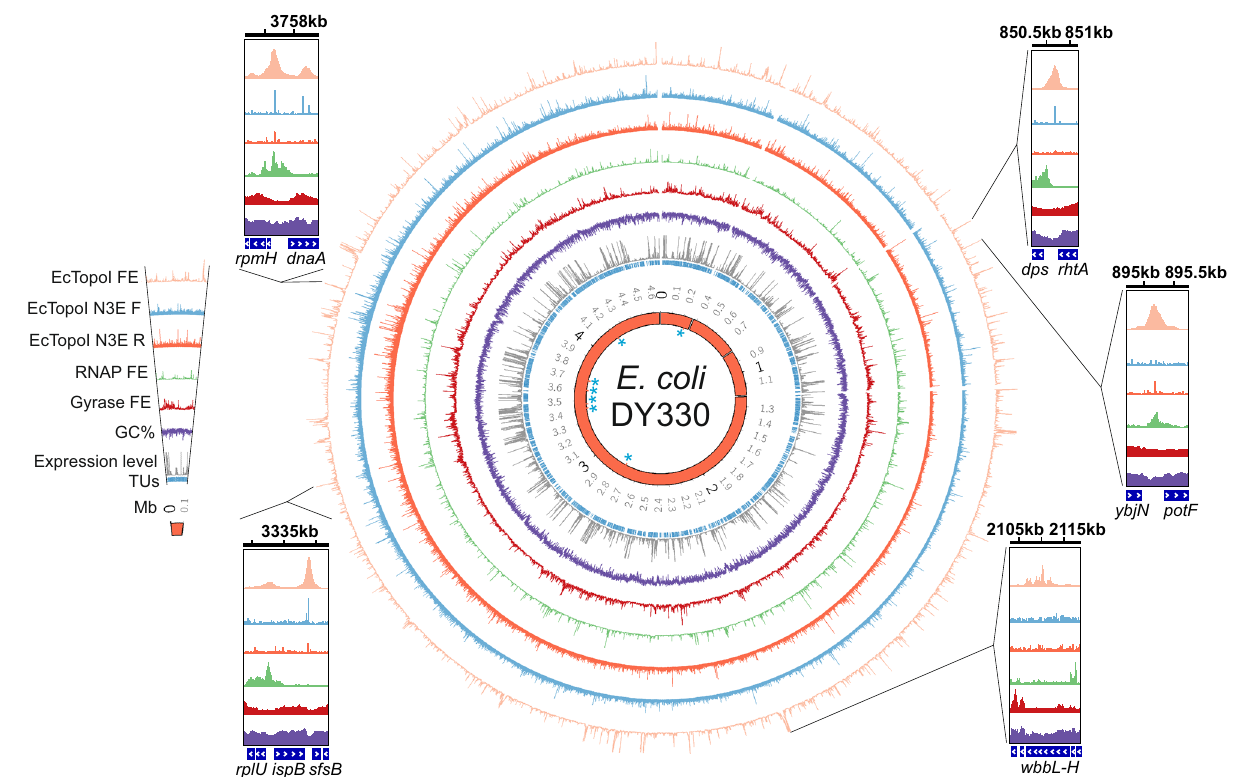
Fig.1|DistributionofEcTopoI,RNAP,andgyraseenrichmentpeaksoverthe E. coli chromosome. Circular maps show fold enrichment pro fi les of EcTopoI (ChIP- Seq, light orange; Topo-Seq, cyan and dark orange for two separate DNA strands), RNAP (ChIP-Seq, green), and DNA gyrase (Topo-Seq, dark-red). Additionally, GC- content (%, purple) and mean expression levels (FPKM, RNA-Seq, gray) for anno- tatedTUs(innerbluesegments)arealsoshown.Blueasterisksindicatepositionsof rRNA operons on the innermost orange ring representing E. coli DY330